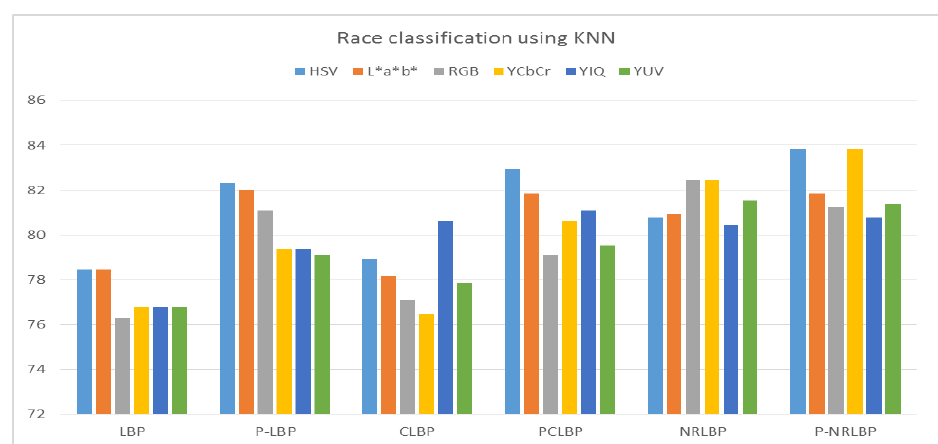
Figure 7. Race classification using KNN (FERET database).